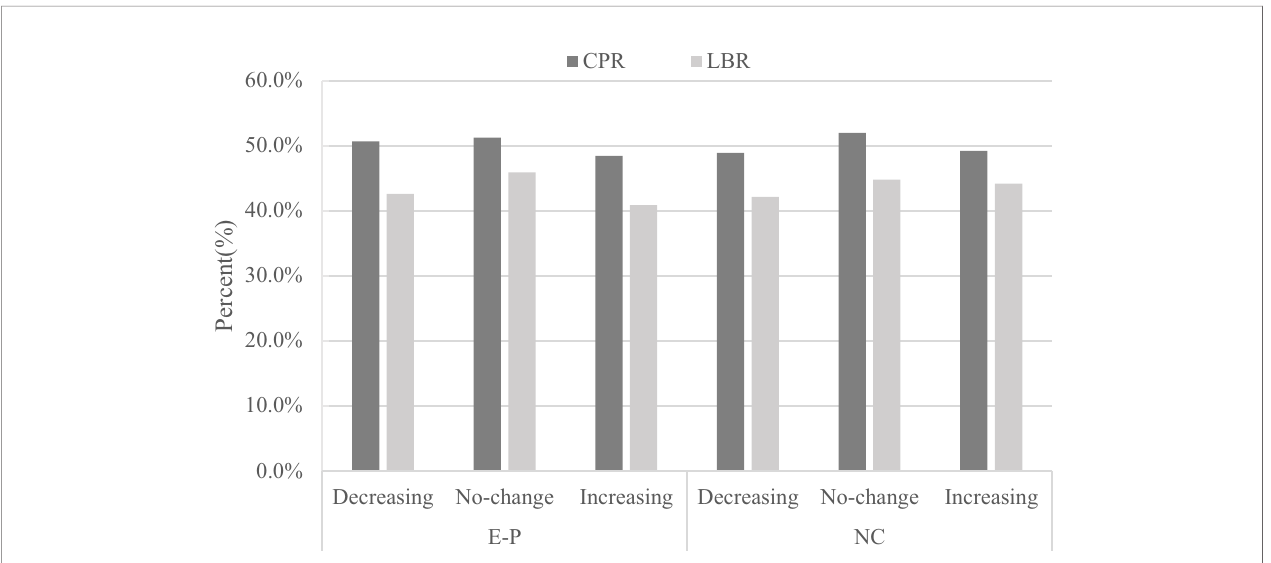
FIGURE 1 | Relationship between endometrium change in response to progesterone and pregnancy outcomes (clinical pregnancy rate and live birth rate). E-P, estrogen-progesterone cycle; NC. natural cycle.